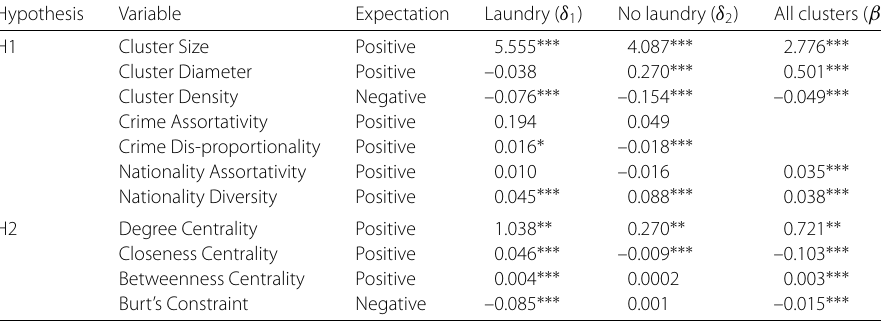
Table 9 Overview of expectations and observed effects of hypotheses; depicting the selected coefficients (columns: δ 1 , δ 2 and β 3 ) from all models (rows) tested and reported, reporting only the combined results of individuals and companies when feasible